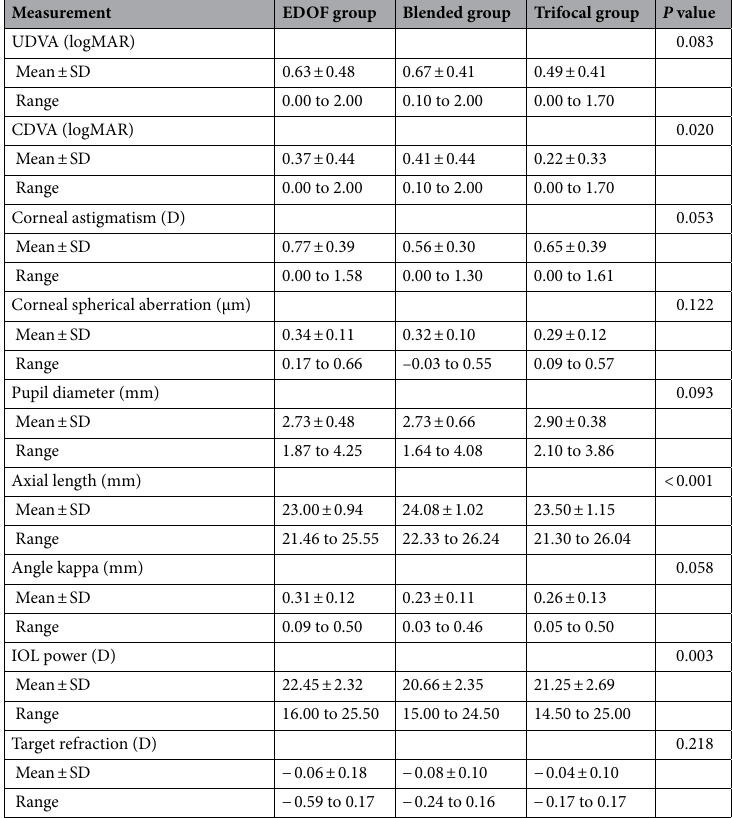
Table 1. Descriptive measures for preoperative ocular characteristics of the EDOF group, blended group and trifocal group. UDVA uncorrected distance visual acuity, CDVA corrected distance visual acuity,